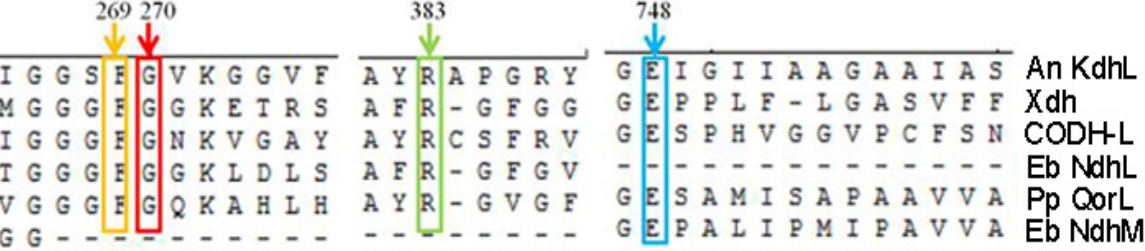
Figure 4. Conserved residues at the catalytic pockets of different molybdenum hydroxylases. Abbreviations—An KdhL: Arthrobacter nicotinovorans KdhL subunit; Xdh: bovine milk Xdh; Pp QorL: Pseudomonas putida 86 quinoline 2-oxidoreductase L subunit; Eb NdhL: Eubacterium barkeri NdhL subunit; CODH-L: Oligotropha carboxidovorans carbon monoxide dehydrogenase L subunit; Eb NdhM: Eubacterium barkeri NdhM subunit.